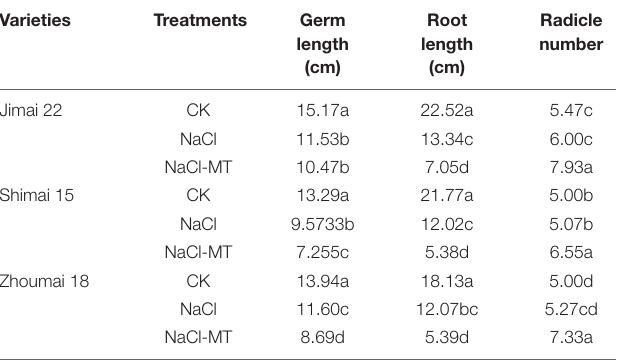
TABLE 2 | Effects of MT on radicle number, root length, and germ length under salt stress.